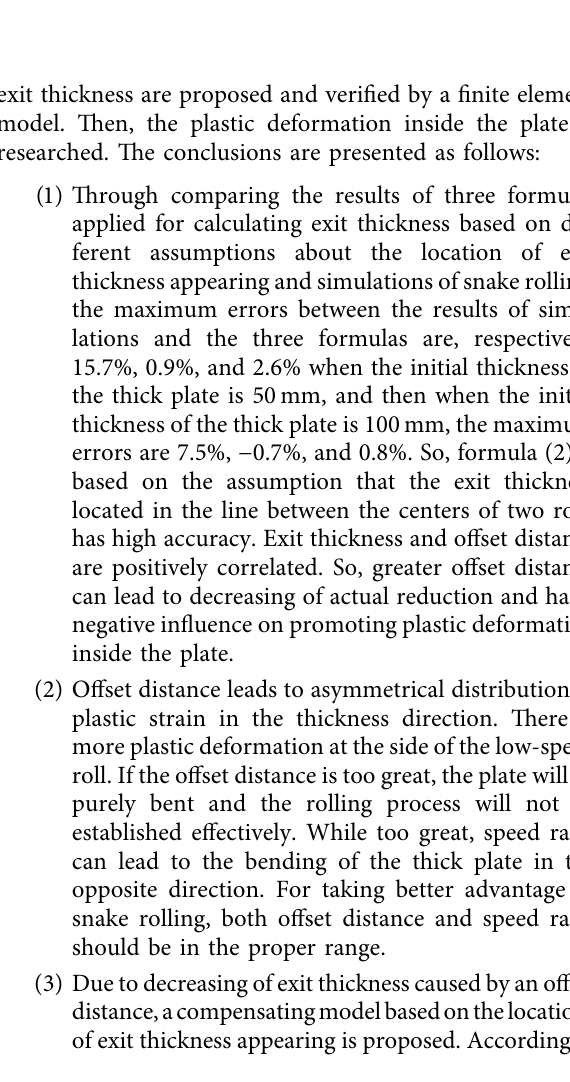
Figure 10: Distribution in thickness direction of equivalent plastic strain inside the plate with speed ratio being 1.05 and exit thickness being compensated: (a) initial thickness is 50 mm and (b)